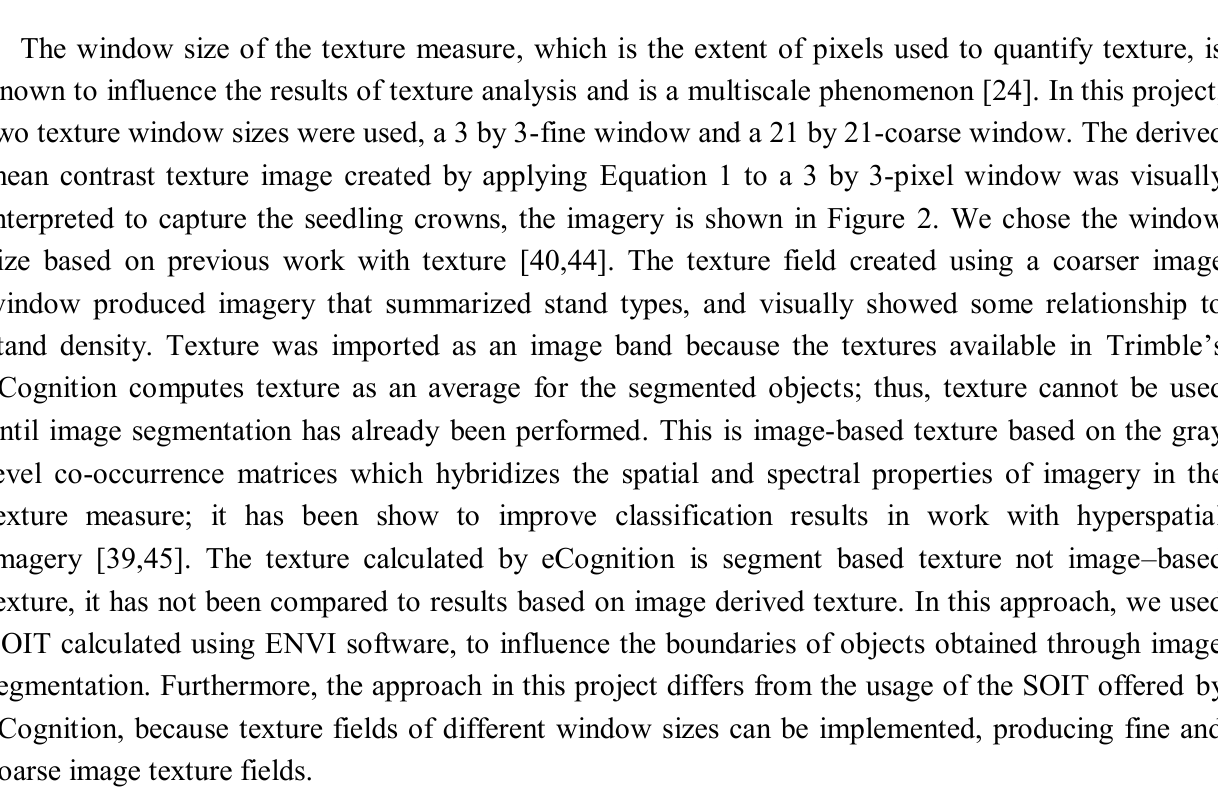
Figure 2. Example of false color composite image and fine image texture used to highlight the seedling crowns in the near-infrared band of the hyperspatial multispectral